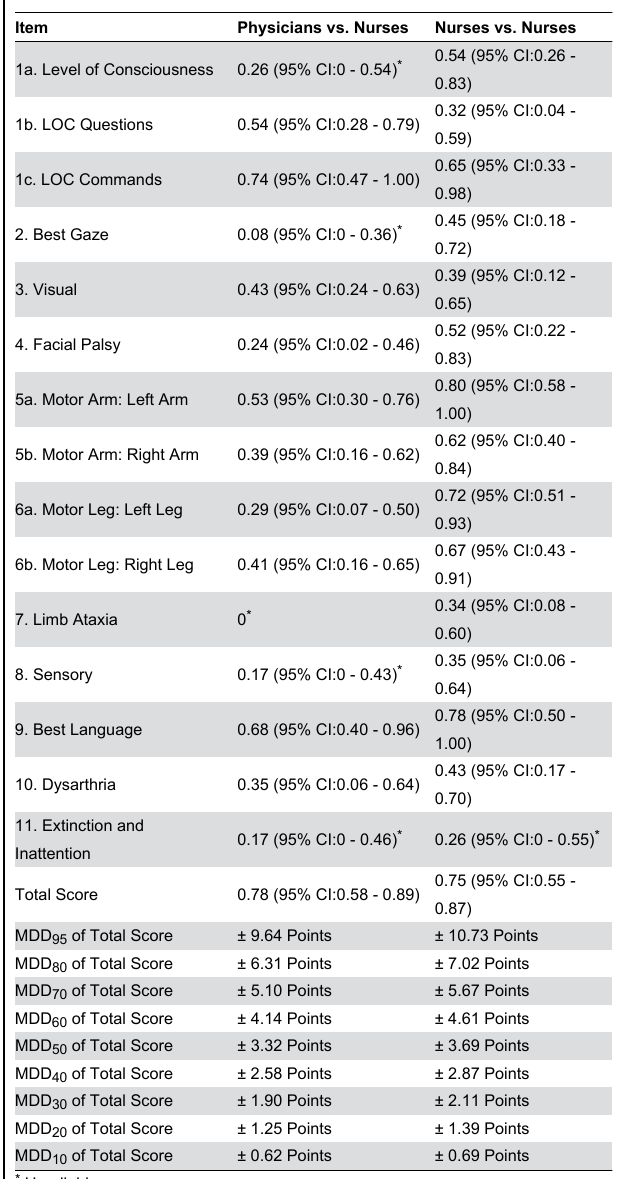
Table 2. The reliability (Kappa for items 1-11 and ICC for total score) and sensitivity to detect change (MDD) of the NIHSS in an uncontrolled clinical